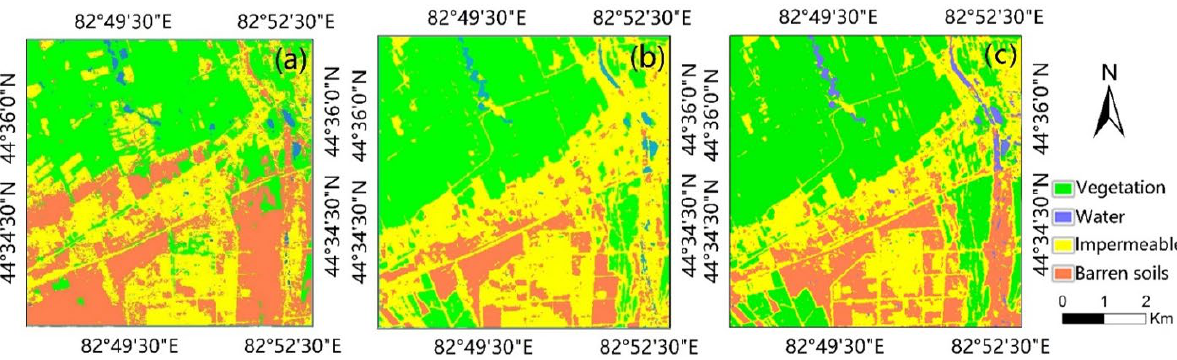
Figure 5. Underlying surface types of region A ( a ) 9 April 2019, ( b ) 24 July 2019, ( c ) 26 August 2019.